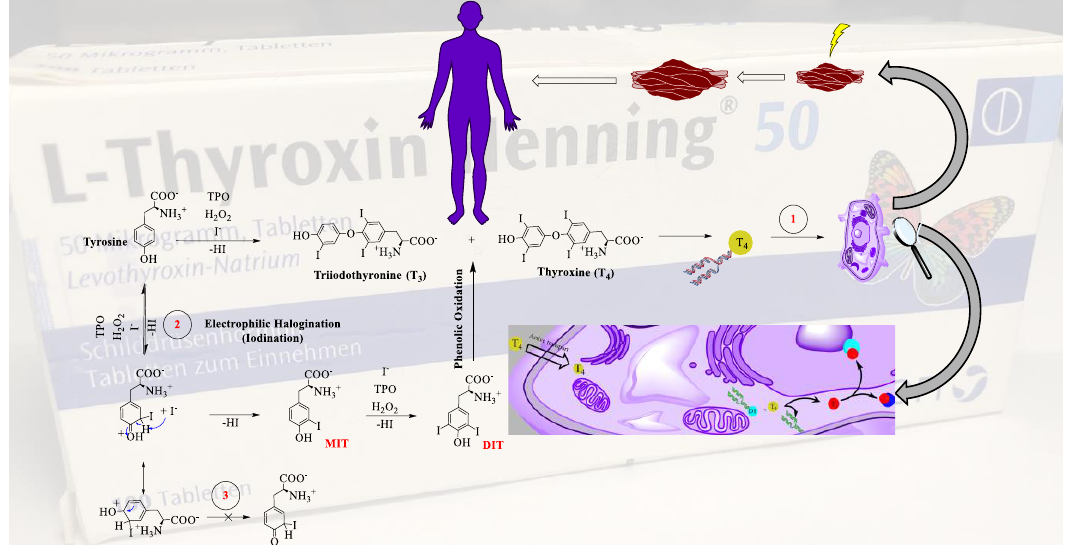
Figure 6. The biosynthesis of thyroid hormones and their impact on healthy muscle growth [5,23,26,27]. This scheme is adapted from two standard pharmacology textbooks, namely, Brenner and Stevens’ Pharmacology 5th edition p. 368 and Basic & Clinical Pharmacology 14th edition p. 688, and purely for illustration purposes, has been expanded to include some additional formulae and